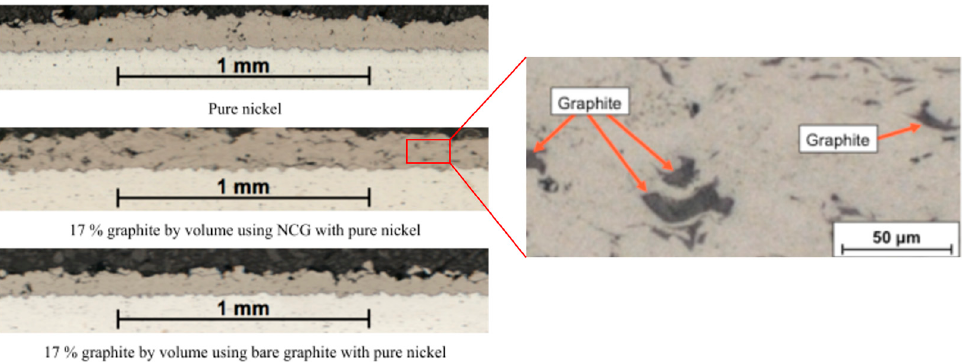
Figure 5. Micrographs showing single passes deposited from nickel, nickel + NCG, and nickel + graphite on aluminium using 1500 W. Graphite can be seen in the nickel + NCG coating. Graphite content and porosity as a function of temperature for a 30 vol% graphite Ni + NCG feedstock is shown in Figure 7 for aluminium and titanium substrates. The maximum graphite content observed in the deposits is 17